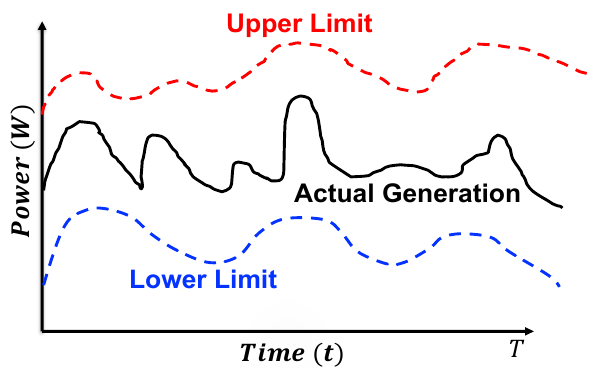
Figure 12. Power supply limitation based on historic